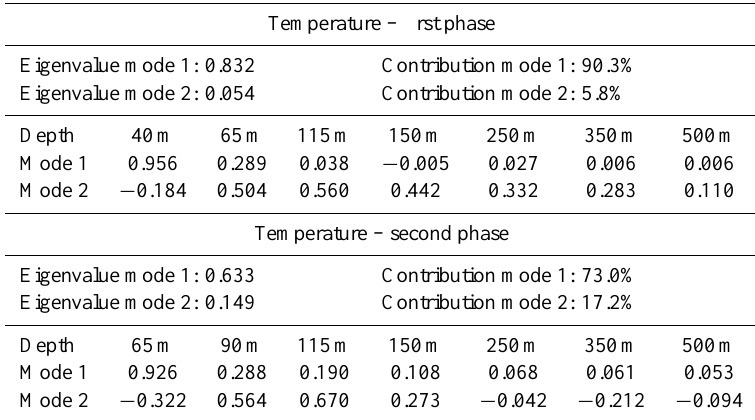
Table 5. EOF eigenvectors and total variance explained for the temperature during the first and second phase (04 Mar 2000 – 01 Jul 2000; J.D. 64 – J.D. 183 and (06 Sep 2000 – 01 Mar 2001; J.D. 250 – J.D. 60)